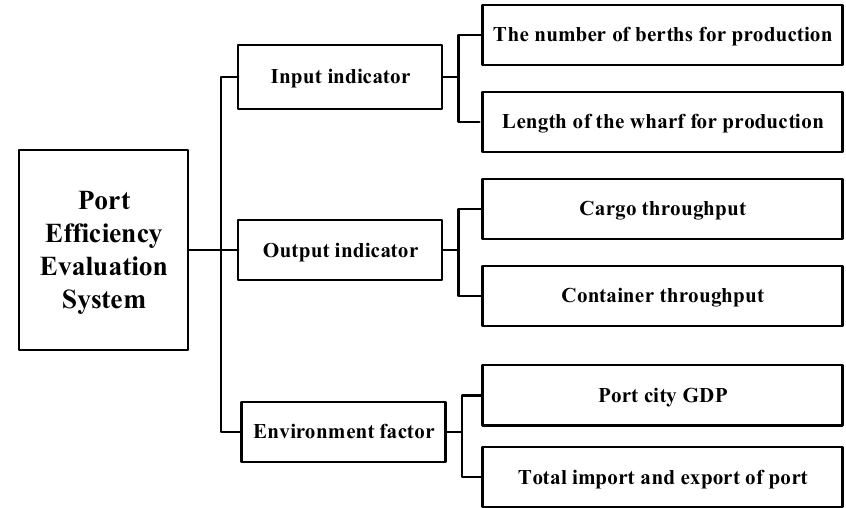
Figure 3. The specific port efficiency evaluation system.